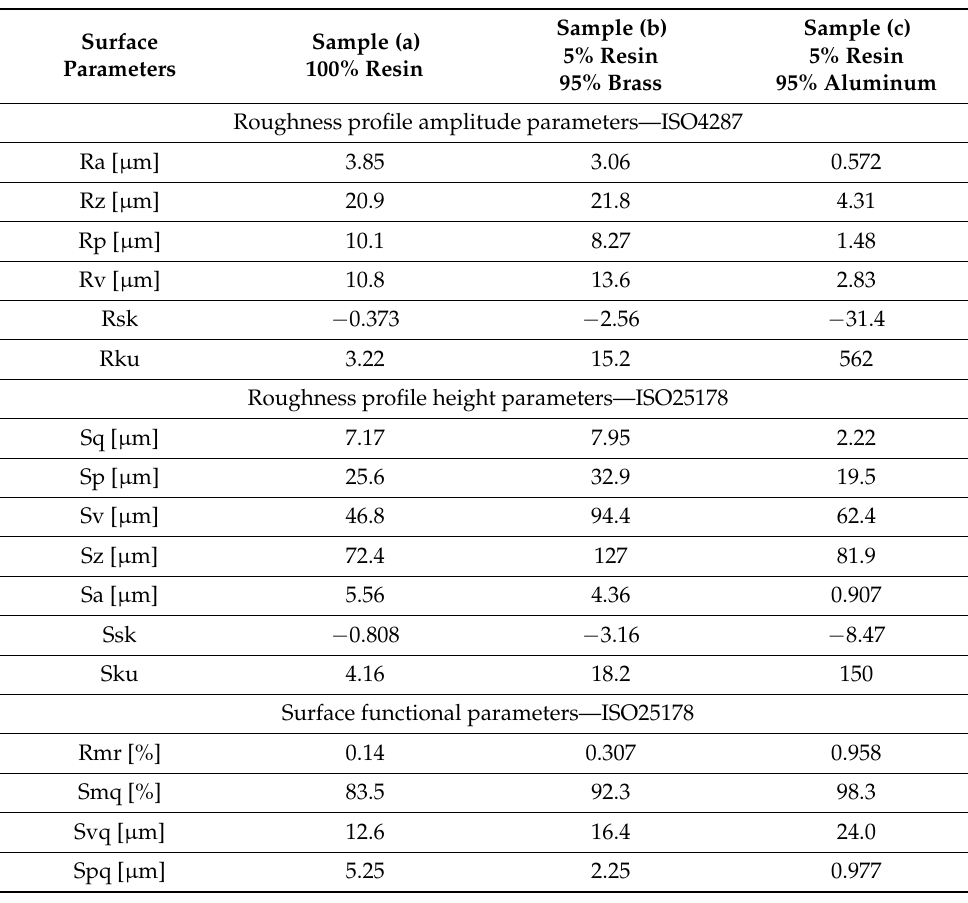
Table 1. Measurement results, surface roughness and functional parameters, measured perpendicular to machining